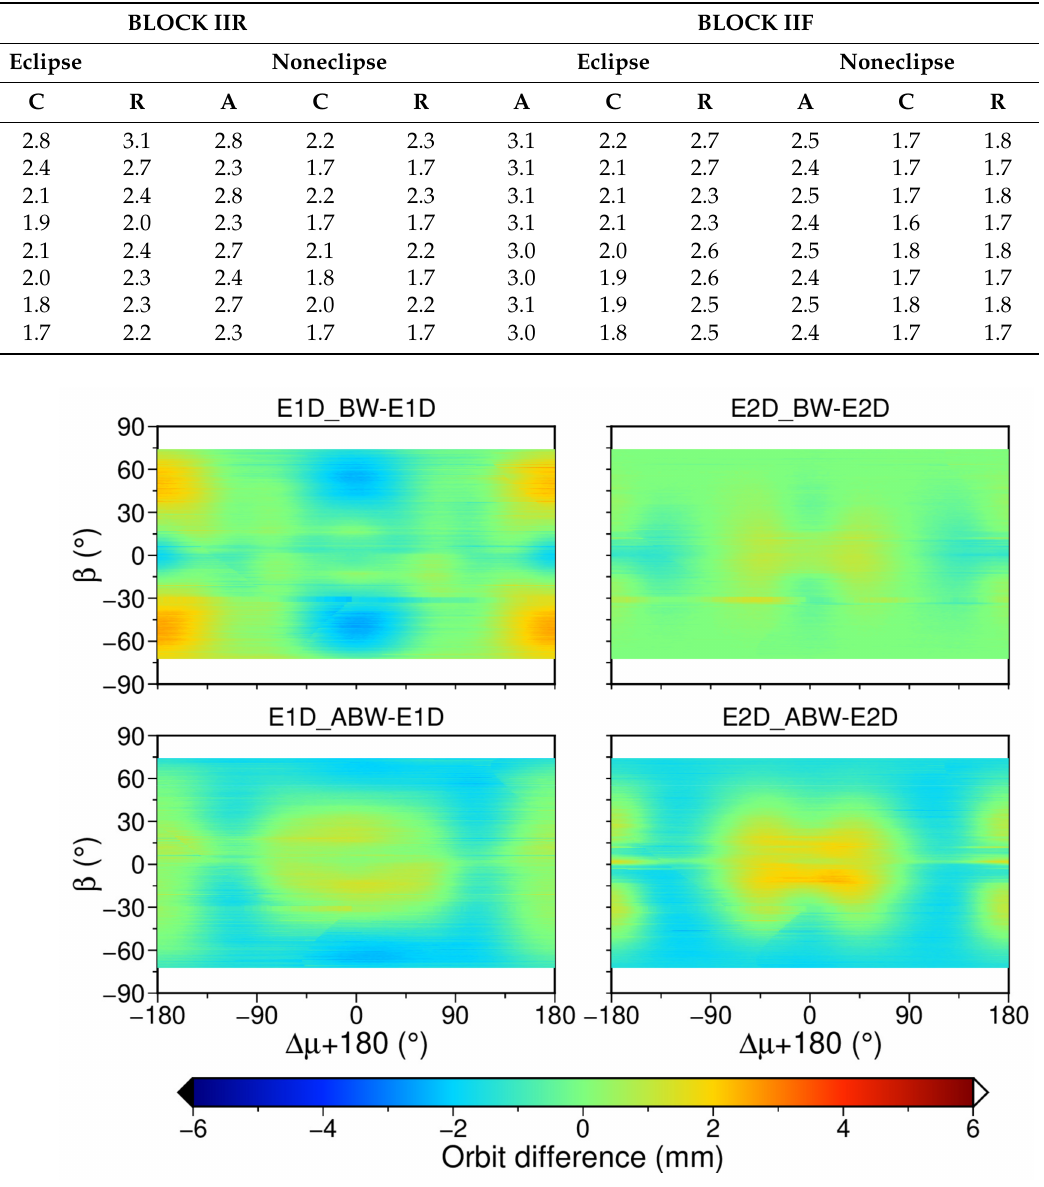
Table 3. RMS values of the orbit DBD in 2017–2019. We distinguish between statistics in and out of eclipse seasons for both BLOCK IIR and BLOCK IIF satellites. A stands for the along direction, C stands for the cross direction, and R stands for the radial direction. The unit is cm. Note that there is no difference between using no a priori SRP model and using the box-wing model; the solutions using the box-wing model are thus not presented.